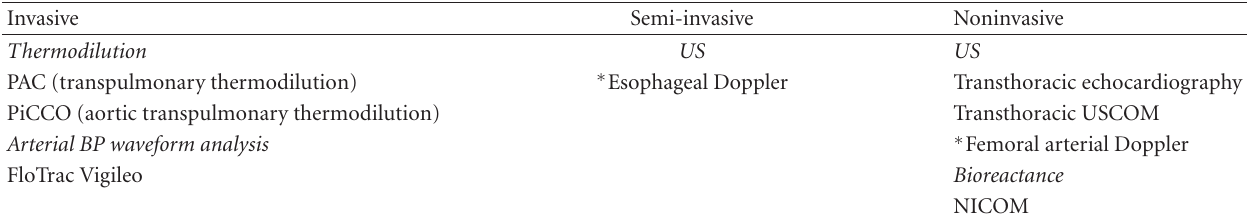
Table 2: Di ff erent methods of measuring CO or arterial blood flow velocity ∗ during PLR